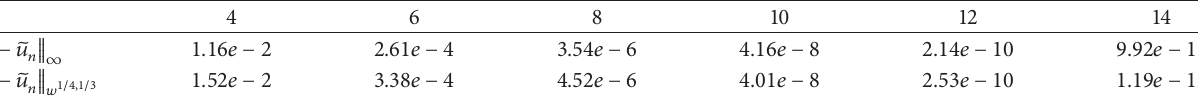
Table 2: The numerical result based on the collocation nodes 𝑥 1/4,1/3 𝑖 , 𝑖 ∈ Z 𝑛